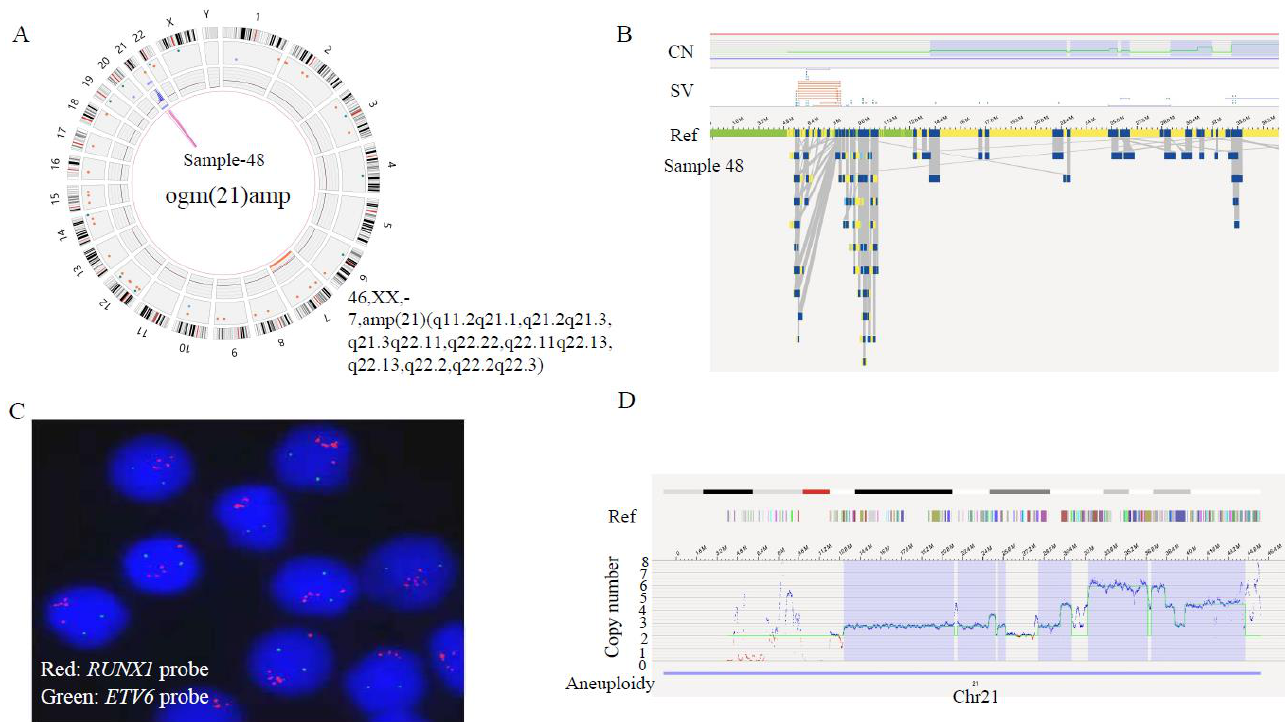
Figure 2. Identification of chromothripsis structures of chromosome 21 in sample 48 by OGM. ( A ) The circus plot illustrated the shattering of chromosome 21, leading to large-scale intra-chromosomal rearrangements. In addition, a monosomy of chromosome 7 was identified (indicated by the red line at the innermost layer of the circus). ( B ) Zoom-in to chromosome 21, showing the aberrant CNV profile(top) and maps of the rare variants (bottom). ( C ) Metaphase-FISH indicated 5 or more RUNX1 signals (red). ( D ) OGM-CNV profile: the green line presents the copy number metrics of each fragment, which means different levels of gain at various breakpoints: 33.2 – 38.1Mb fragment with CN = 6, 39.2 – 39.9Mb fragment with CN = 4, 39.9 – 40.8Mb fragment with CN = 3, 40.8 – 45.5Mb fragment with CN = 4.